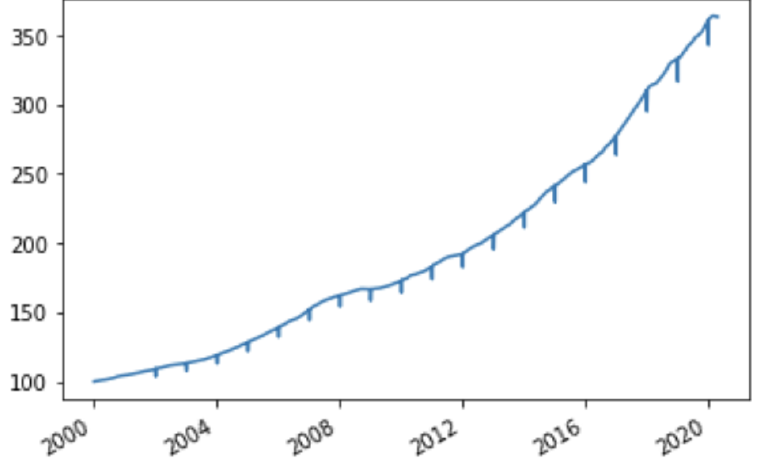
Figure 13. Monte Carlo simulations over a time horizon of 20 years for the portfolio with ML volatility (source: authors’ calculations).